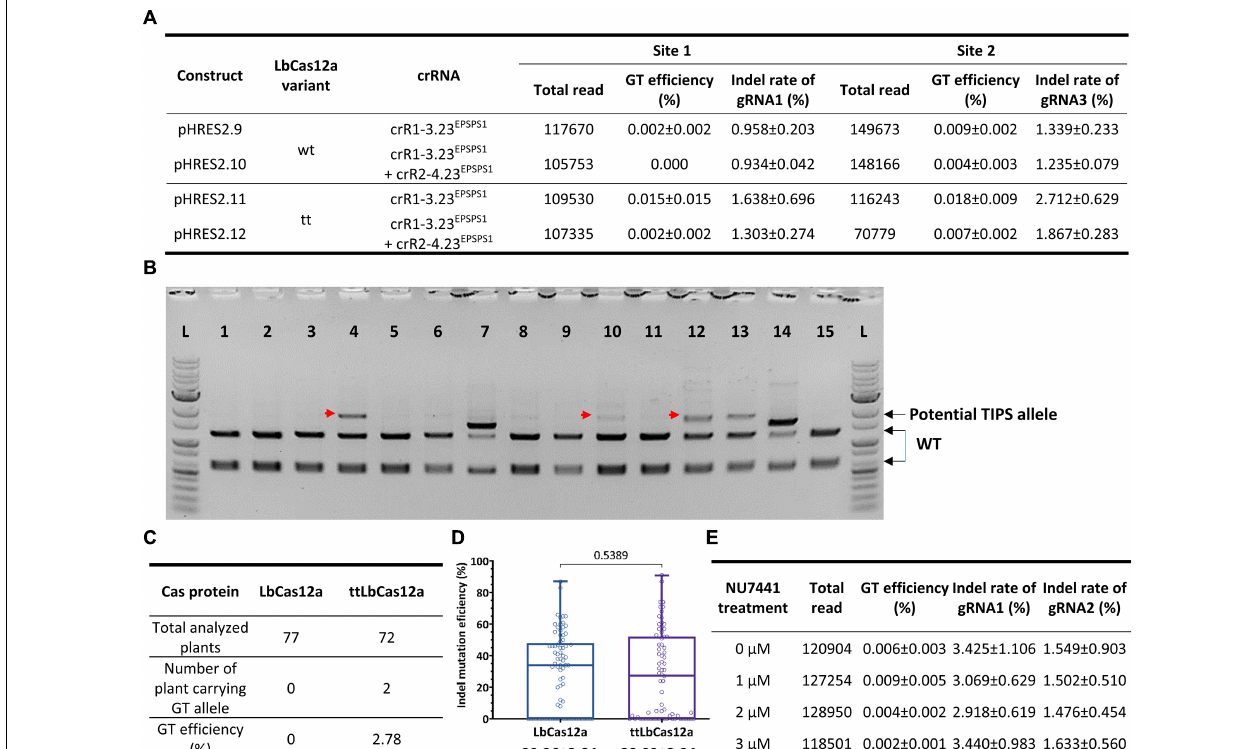
FIGURE 5 | Further assessment of GT performance of the LbCas12a variants at the SlEPSPS1 locus. (A) Assessment of GT efficiency by targeted deep sequencing with GT tools using two or four cutting sites with LbCas12a variants at the SlEPSPS1 locus. (B) Screening of potential GT events using the CAPS assay at the plant stage. Transformants of each LbCas12a variant were obtained from the transformation of the GT tool with the crR1-2.23 EPSPS1 expression cassette and used for genomic DNA isolation and PCR amplification of the targeted site with the UPEPSPS1-F2 and DNEPSPS1-R1 primers. The PCR products were purified and digested by the Bpi I restriction enzyme since the Bpi I site near the targeted site was modified in the DNA donor sequence. The red arrows indicate potential GT bands. 1–15: Representative transformants obtained from the transformation using the GT construct containing LbCas12a and crR1-3.23 EPSPS1 . (C) TIPS GT efficiencies obtained with the wt LbCas12a and ttLbCas12a. All the purified PCR products of the transformants that showed undigested bands at WT band size (2,314 bp) in the CAPS assay were analyzed by targeted deep sequencing. Only the transformants carrying more than 5% of the TIPS allele were counted as GT events. (D) Boxplots showing indel mutation efficiency induced by LbCas12a and ttLbCas12a. All the purified PCR products used in the CAPS assay were sequenced by the Sanger method, and the ab1 files were subsequently analyzed by ICE Synthego software to reveal the indel mutation and GT efficiencies. The indel mutation efficiencies of all the samples were statistically analyzed using Student’s t -test (unpaired, two-tailed, uncorrected) and plotted by GraphPad Prism version 9. The editing efficiencies (mean ± SEM) are shown at the bottom of each box. (E) Targeted deep sequencing-mediated evaluation of NU7441 impacts on ttLbCas12a-based GT efficiency.